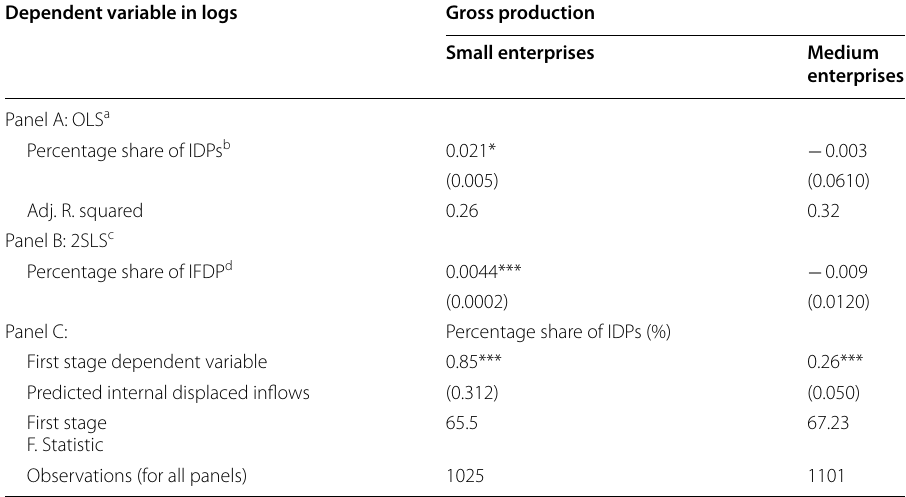
Each coefficient corresponds to a separate regression and all panels include controls for zone and year fixed effects. The standard errors clustered at the zonal level are shown in the parenthesis. *** Represents significant level at 1%, ** represents significant at 5% and * represents significance at 10* a Ordinary least square estimation b Internal displaced populations c Two-stage least square estimation